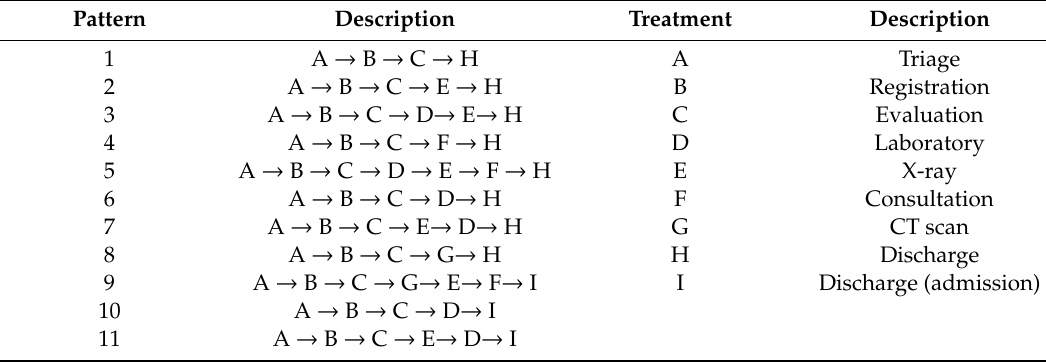
Table 1. Patient treatment pattern.